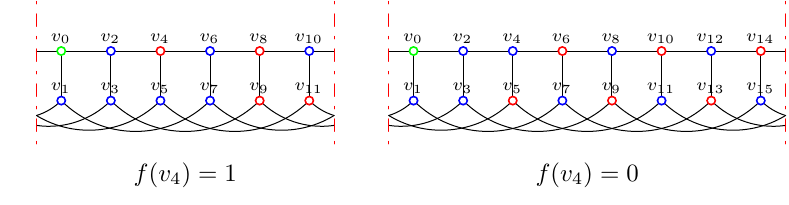
Figure 6. Segments of f in Case 1.2 in Lemma 7.